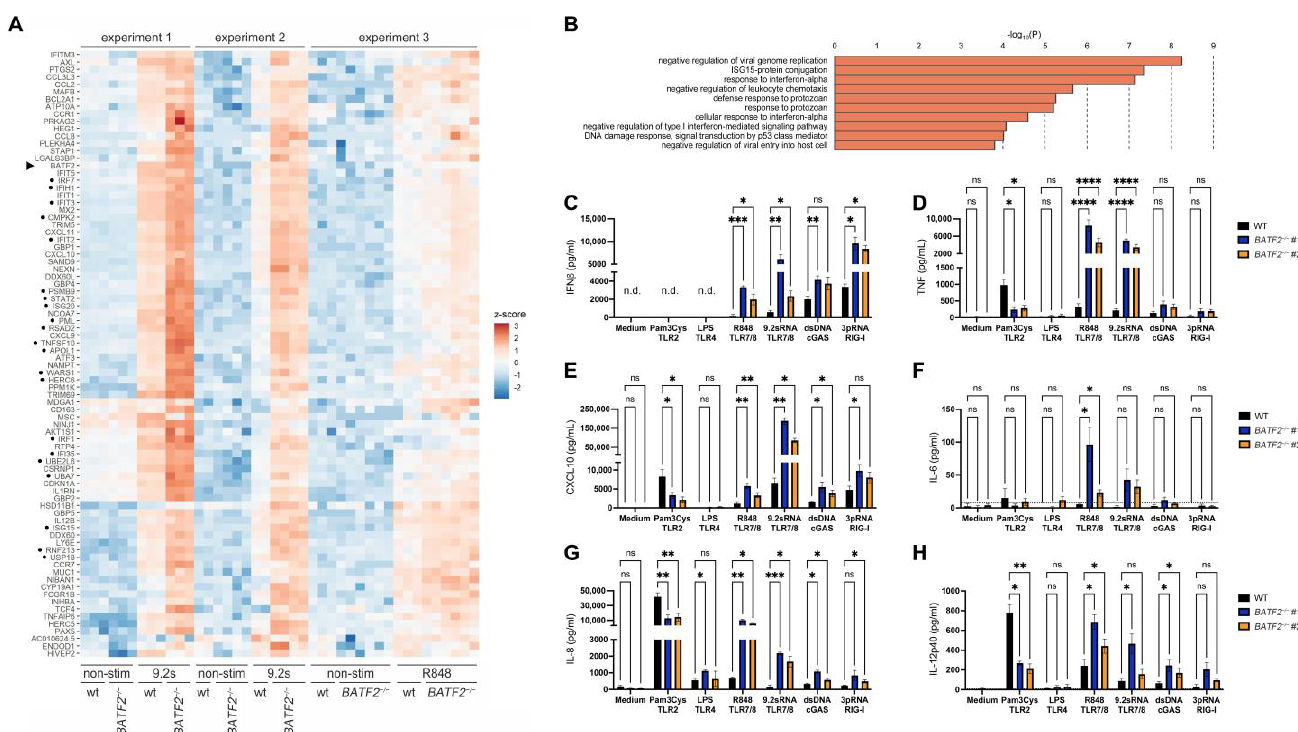
Figure 3. Knockout of BATF2 leads to elevated TLR7/8 stimulation and repressed TLR2 response in THP-1 cells. ( A ) Differentially expressed genes in BATF2 −/− and wild-type THP-1 cells identified by 3′ RNA sequencing. Heatmap of z -scores of normalized transcript counts is shown for genes that were significantly upregulated upon TLR7/8 stimulation in BATF2 −/− cells (FDR < 0.05) and displayed at least 2-fold higher upregulation in BATF2 −/− in comparison to wild-type cells in at least two of the three independent experiments. BATF2 −/− and wild-type (WT) THP-1 cells were stimulated with 2 µg/mL R848 or 7.5 µg/mL 9.2 s RNA. Genes associated with type I interferonopathies [28] are indicated by dots. Arrowhead, BATF2. ( B ) Gene ontology pathway enrichment analysis of upregulated genes. Only pathways with at least 30-fold enrichment and more than two hits are shown. ( C – H ) Cytokine release is upregulated upon TLR7/8 and cGAS stimulation and downregulated upon TLR2 stimulation in BATF2 −/− THP-1 cells. BATF2 −/− and wild-type (WT) THP-1 cells were stimulated with 2 µg/mL Pam3Cys, 2 µg/mL LPS, 500 ng/mL R848, 2µg/mL 9.2 s RNA, 250 ng/mL dsDNA, or 100 ng/mL 3pdsRNA. Cellular supernatants were harvested for ELISA measuring IFN- β (coded by gene IFNB1 ) ( C ), TNF ( D ), CXCL10 ( E ), IL-6 ( F ), IL-8 (coded by gene CXCL8 ) ( G ), or IL-12p40 (coded by gene IL12B ) ( H ). The dotted line denotes the detection limit of the ELISA used. Arithmetic mean ± SEM from three independent experiments is presented. Statistical significance was analyzed via two-way ANOVA with Dunnett’s correction. *, p < 0.05; **, p < 0.01; ***, p < 0.005; ****, p < 0.001.